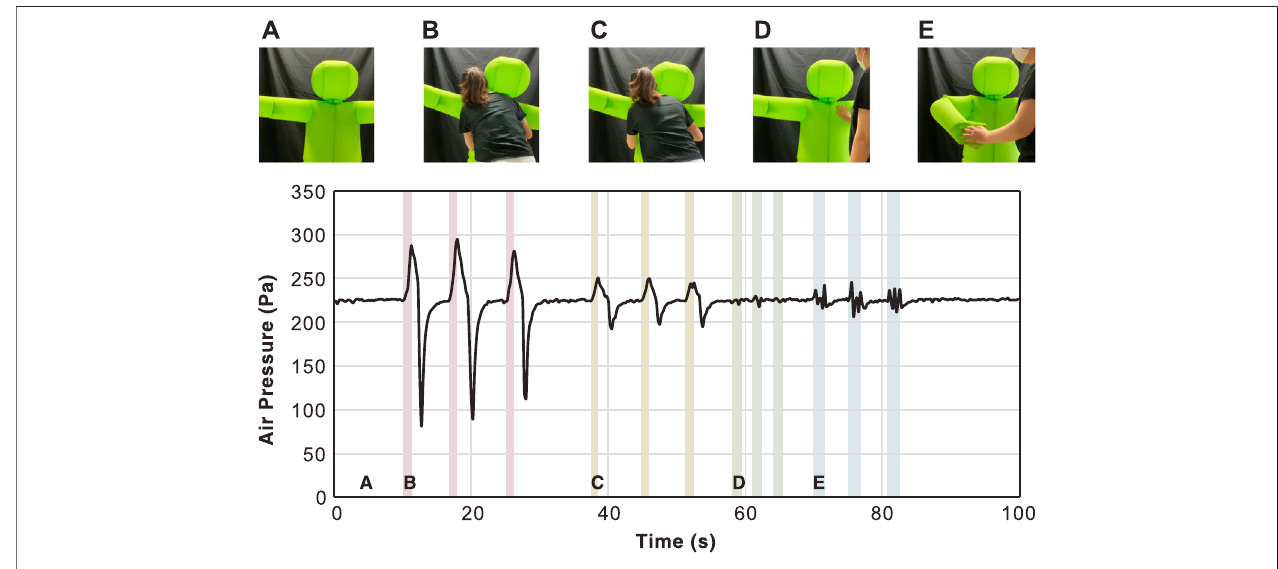
FIGURE 13 | Changes in air pressure caused by physical interactions. (A) : Neutral, (B) : Hugging tightly, (C) : Light hug, (D) : Thumping, and (E) :